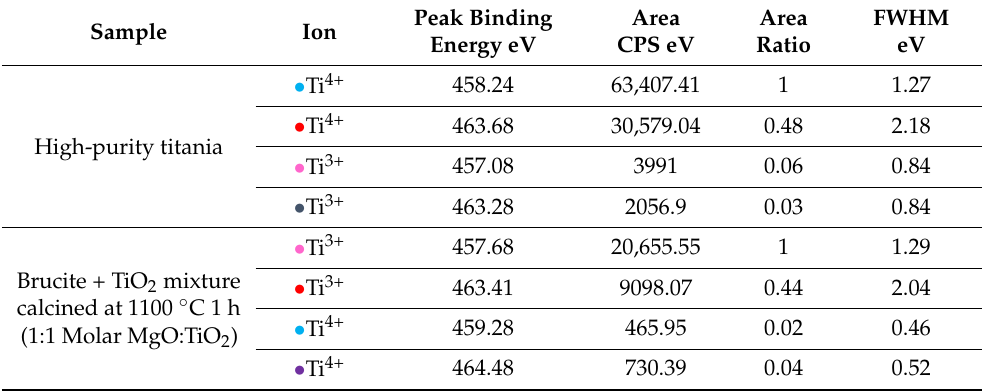
Figure 7. XPS high-resolution spectra of O1s in mixture of brucite and titania, calcined at 1100 ◦ C for 1 h, for formulation M1. Table 5. Details of the data obtained from the XPS analysis of Ti for samples of pure titania and mixture of brucite with titania, with the latter heat treated at 1100 ◦ C for 1